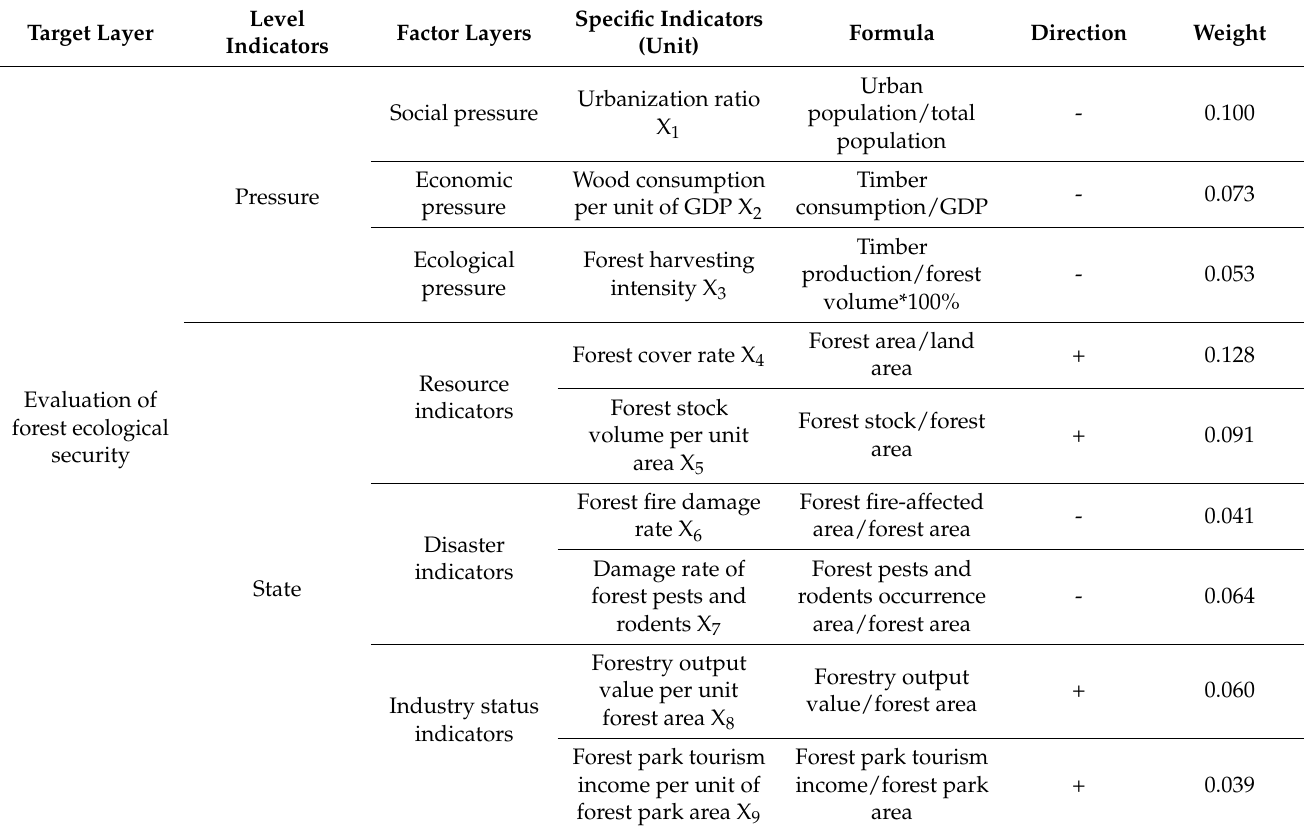
Table 1. The evaluation index system of Forest Ecological Security